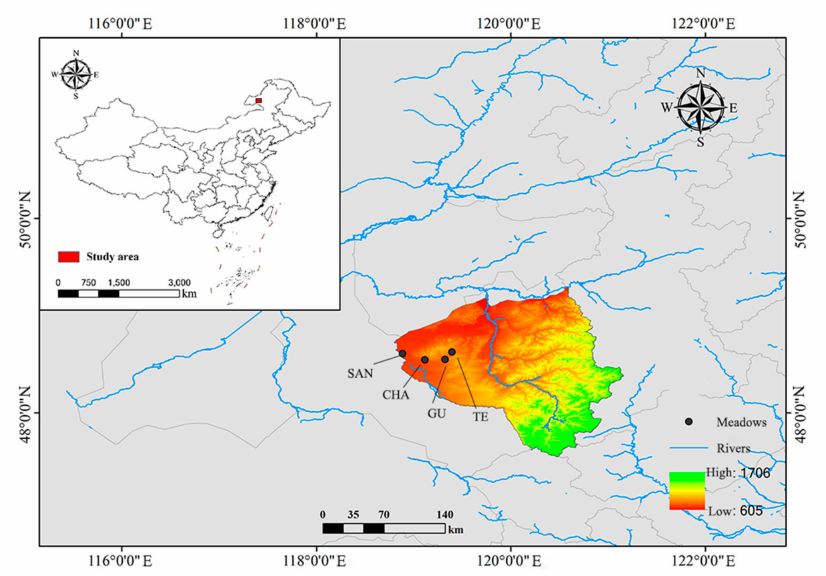
Figure 1. Geographical locations of meadows at four di ff erent time of fencing. SAN: light grazing. CHA: fenced for three years. GU: fenced for seven years. TE: fenced for ten